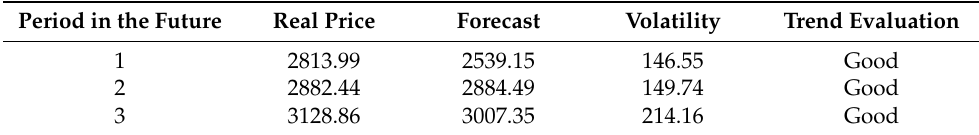
Table 15. Forecasts of the eight-terms group of the Second Board Index. Period in the Future